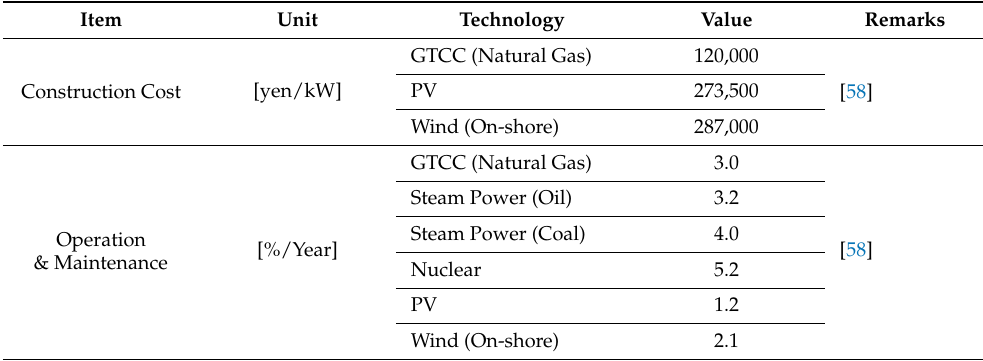
Table A1. Properties of each type of technology are shown in the following